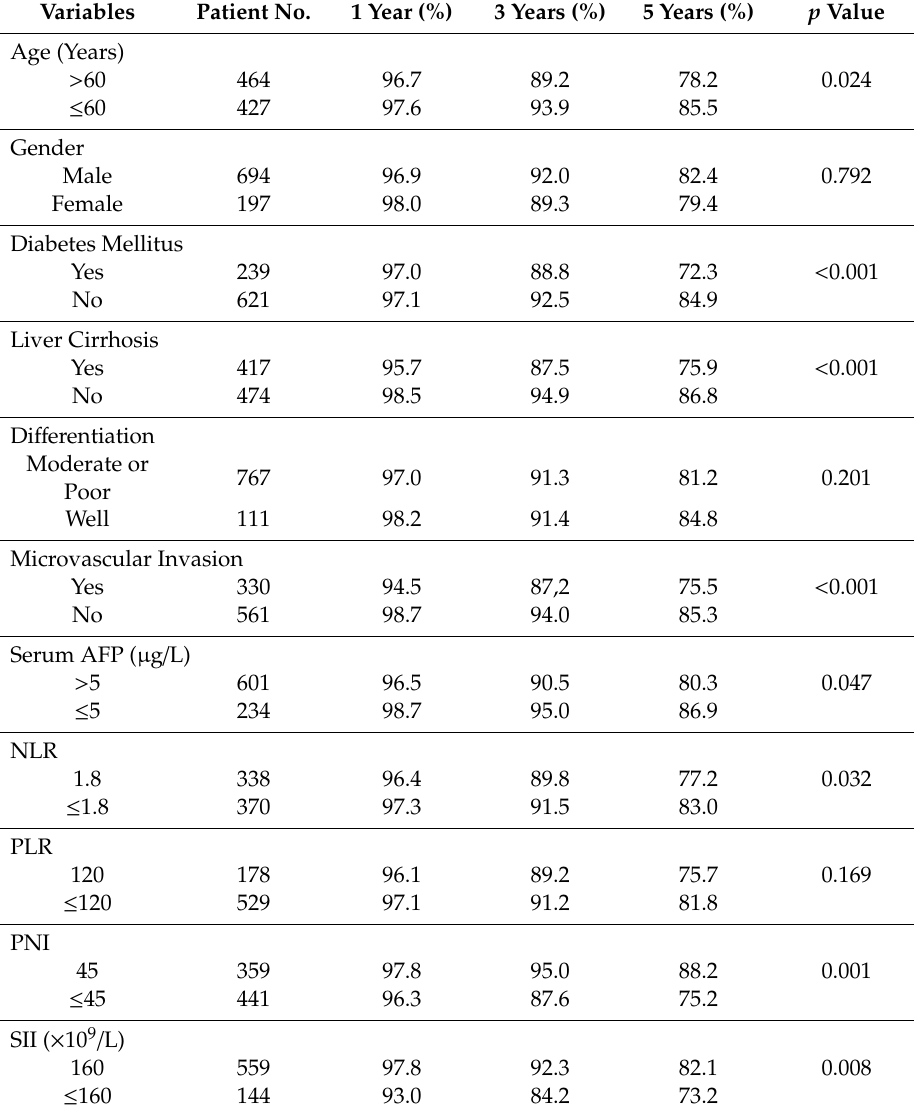
Table 3. Cumulative survival rates in BCLC 0-A HCC patients after hepatectomy.